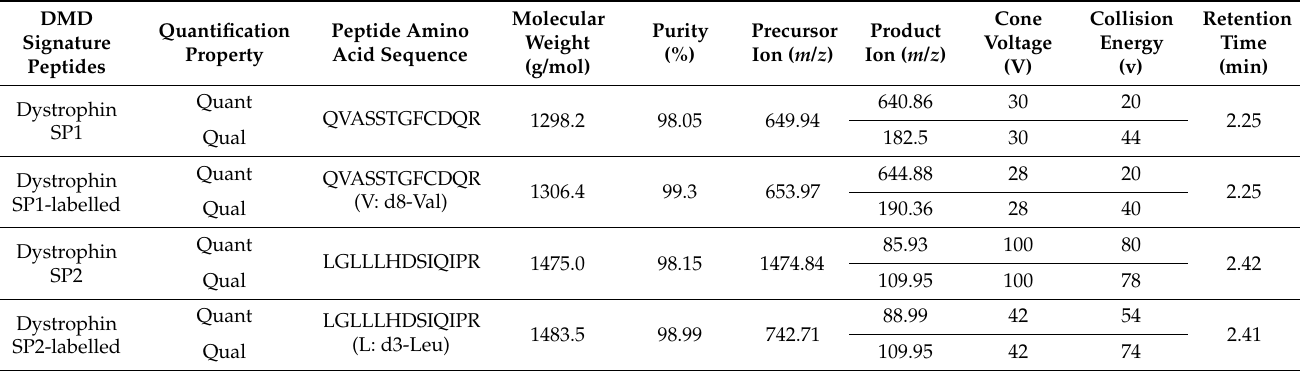
Table 1. List of dystrophin signature peptides and their internal standard details, including the instrumental conditions. The underlined valine and leucine moieties were labeled with d8 and d3,